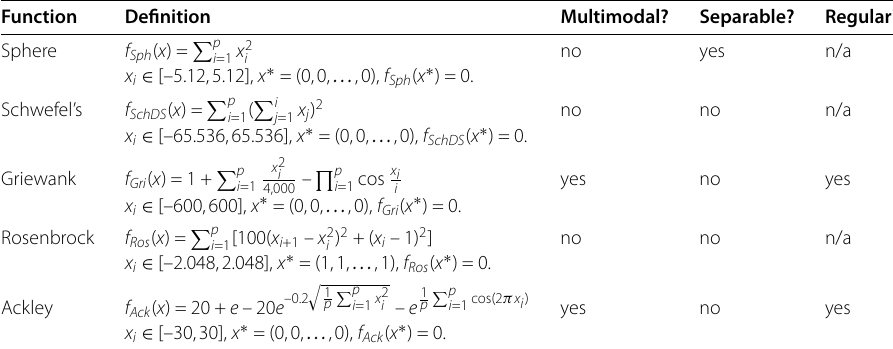
Table 2 Definition of the benchmark problems and their features